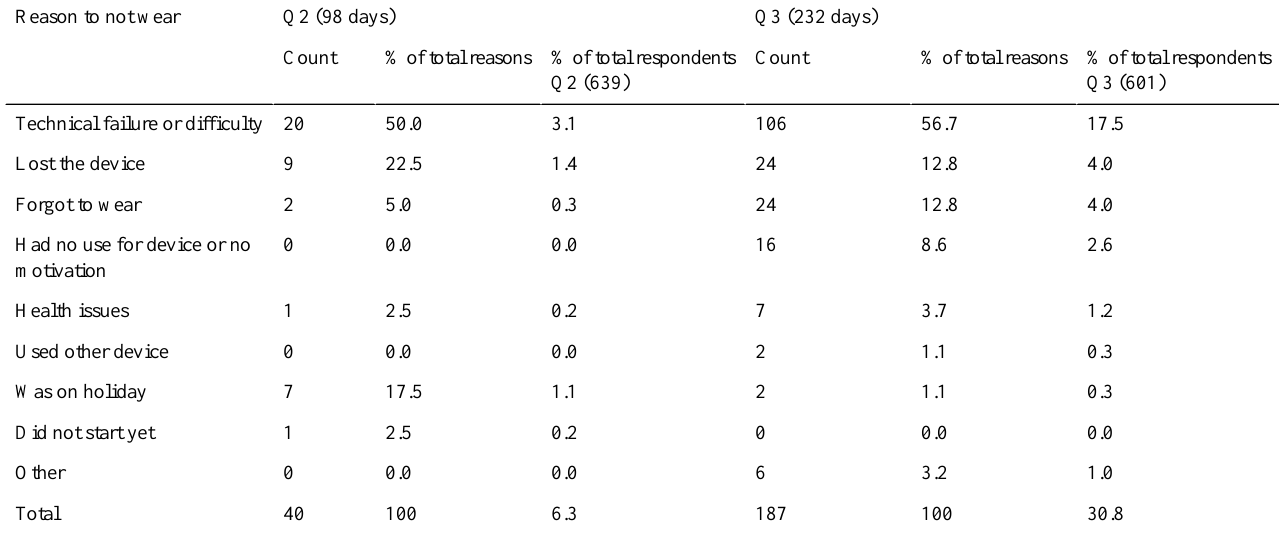
Table 2. Reasons for not wearing the